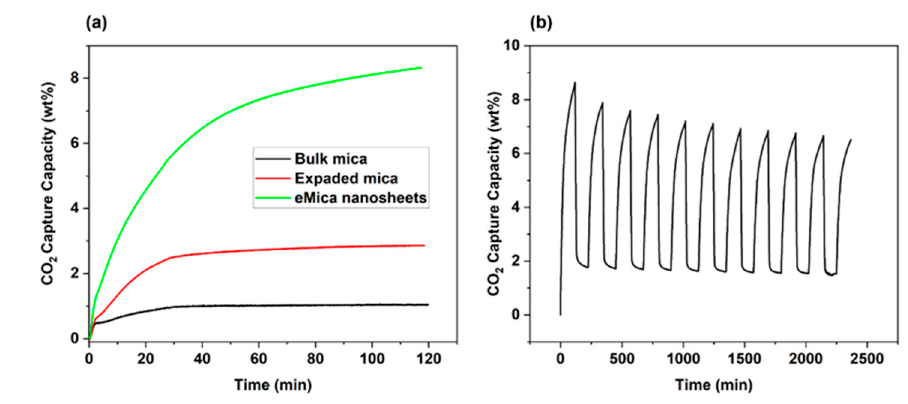
Figure 5. ( a ) CO 2 adsorption isotherm at room temperature and ( b ) cyclic isotherm of adsorption and desorption.